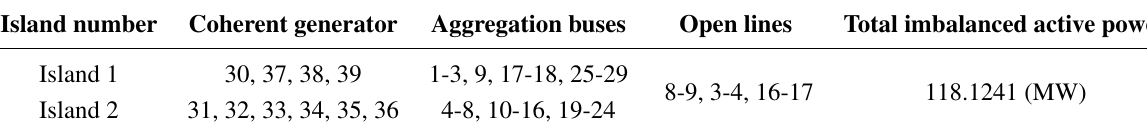
Table 3. Spectral partitioning result (39-bus system).